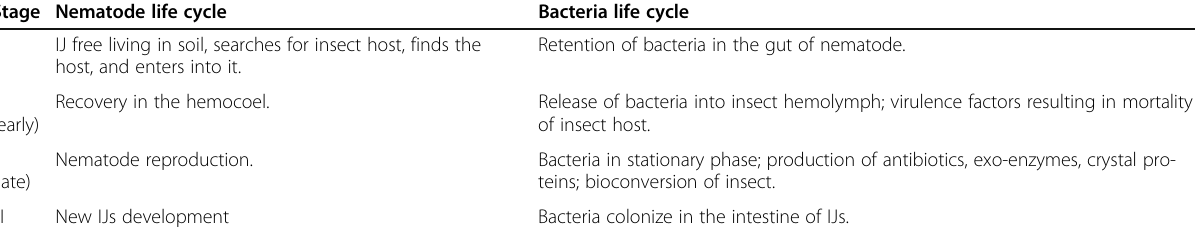
Table 1 Life cycle events in the nematode-bacteria symbiosis Stage Nematode life cycle Bacteria life cycle